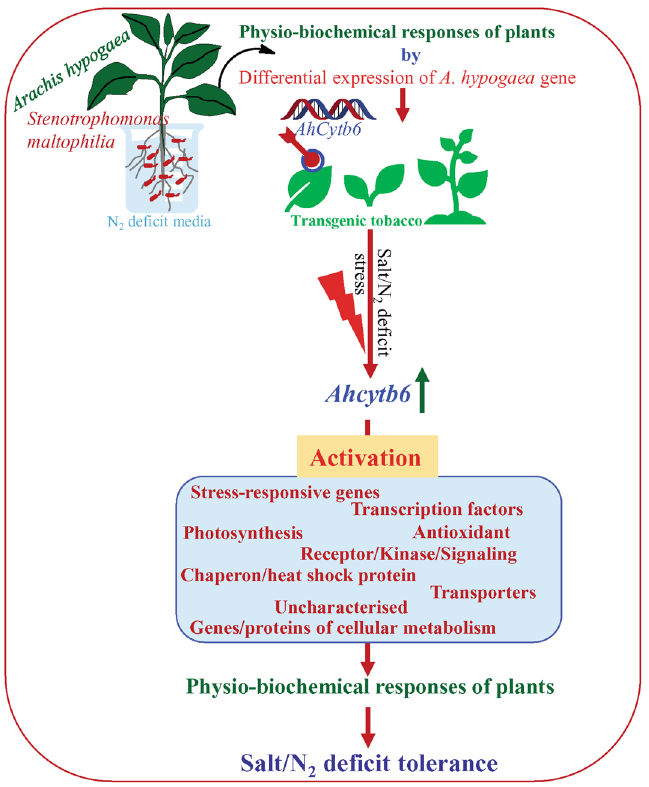
Figure 8. A hypothetical schematic model explaining the probable role of the AhCytb6 abiotic stress tolerance